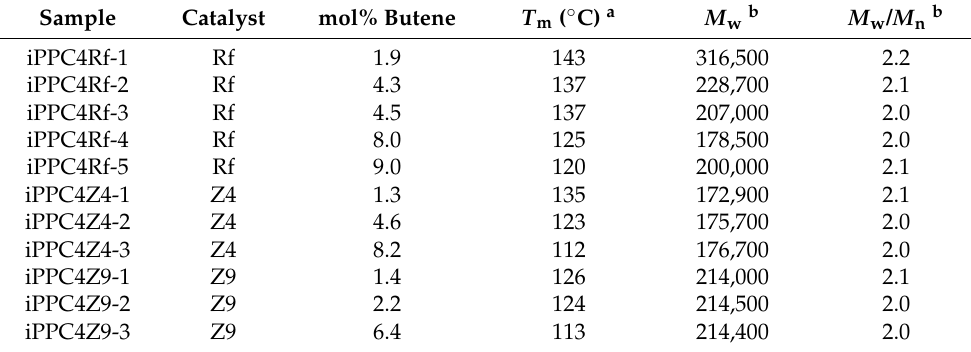
Table 1. Catalyst, composition (mol% butene), melting temperature of as-prepared samples ( T m ), molecular mass ( M w ) and dispersity ( M w / M n ) of the iPPC4 copolymers [79].